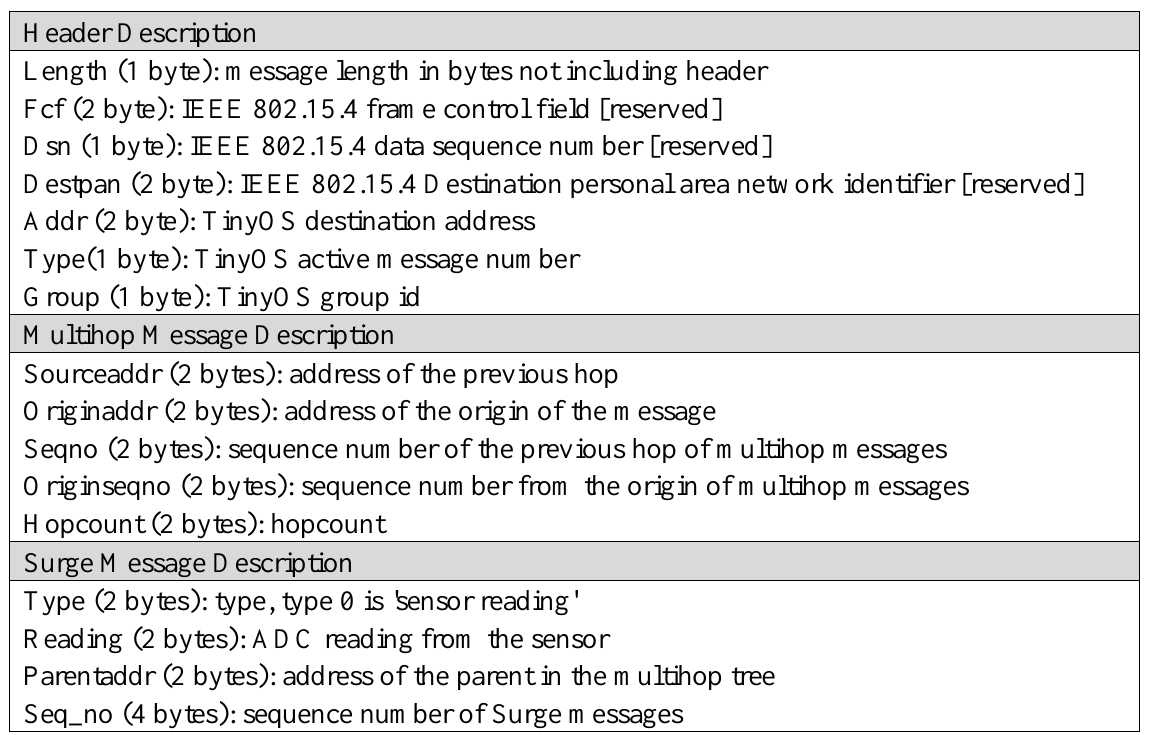
Table 1. TIP 700CM sensor message